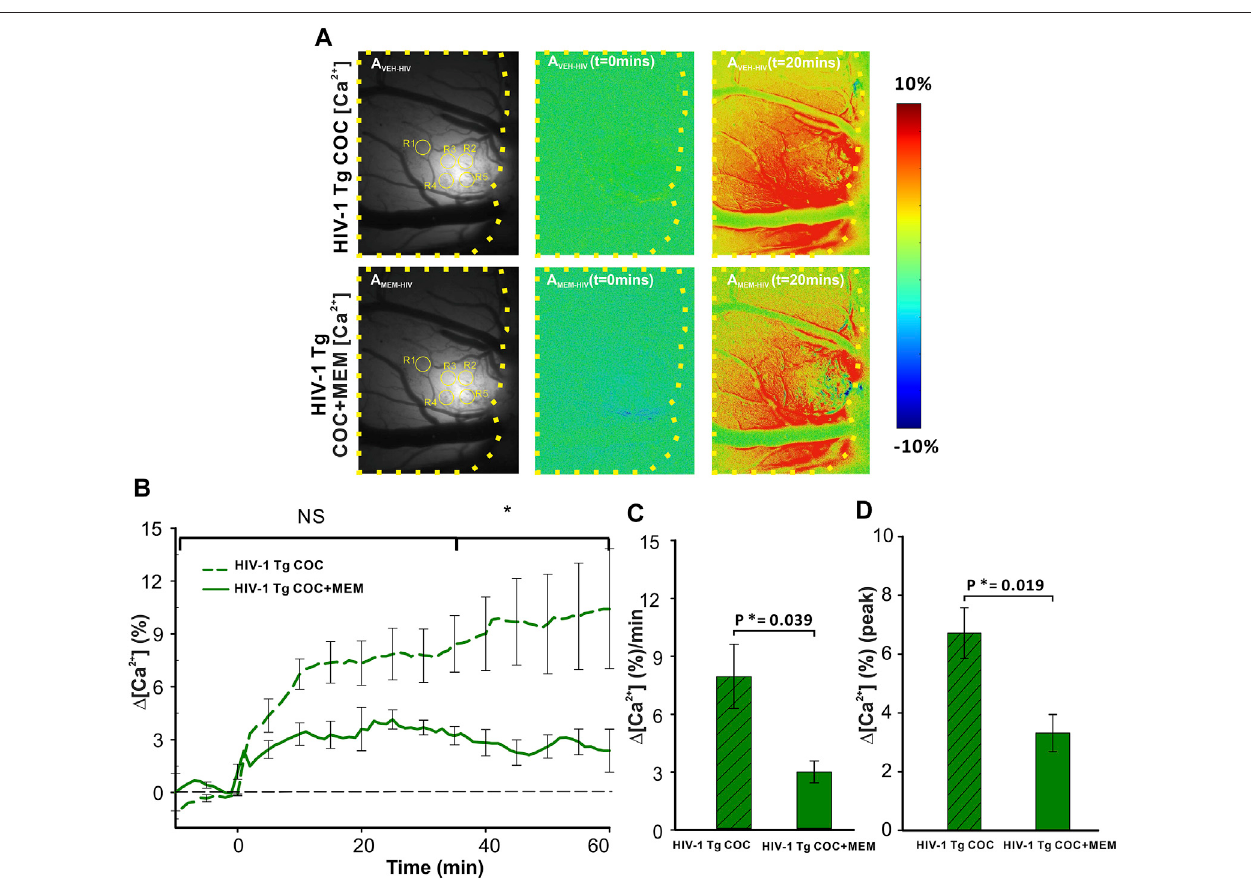
FIGURE 6 | Attenuated neuronal Δ [Ca 2+ ] i response to cocaine with memantine pretreatment in HIV-1 Tg rats. (A) Representative images of the [Ca 2+ ] i fl uorescent dynamics in the PFC, illustrating how the response varies spatiotemporally in the PFC of HIV-1 Tg rats. Upper panels represent the response in vehicle-pretreated animals,whereasthelowerpanelshowsthePFCresponsetococaineinmemantine-pretreatedHIV-1Tgrats. (B) Timecoursesofneuronal Δ [Ca 2+ ] i fl uorescentchanges inboththevehicleandmemantinepretreated rats,includingtheattenuationofcocaine-inducedneuronal Δ [Ca 2+ ] i withmemantinepretreatment. (C) Mean Δ [Ca 2+ ] i change rate and (D) peak of the Δ [Ca 2+ ] i signals were signi fi cantly reduced in memantine-pretreated rats. Values in graph represent the mean and standard error. The region of the PFC encircled by a yellow line represents the brain region of interest. ROIs quanti fi ed are contained within yellow circles in A VEH-HIV and A MEM-HIV . NS: not signi fi cant. *: p < 0.05, signi fi cant